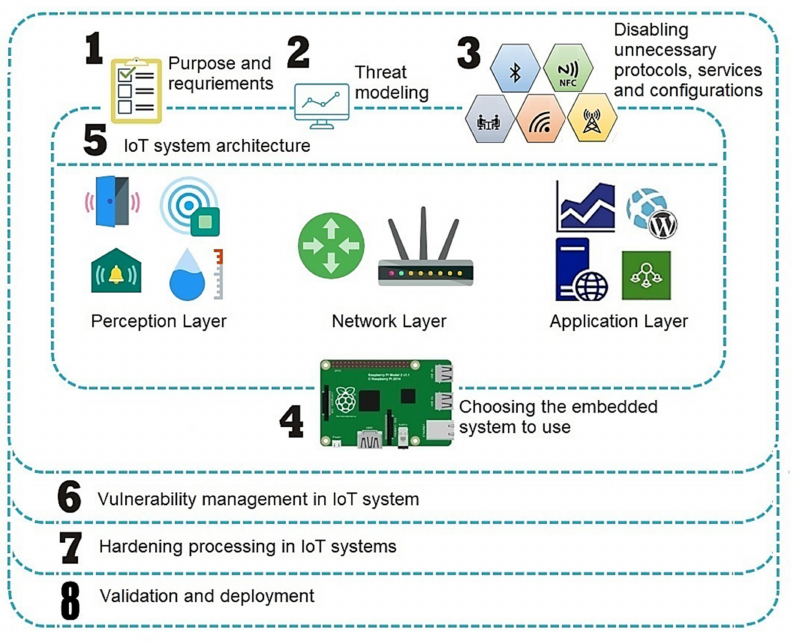
Figure 5. Proposed model for security hardening on IoT systems.